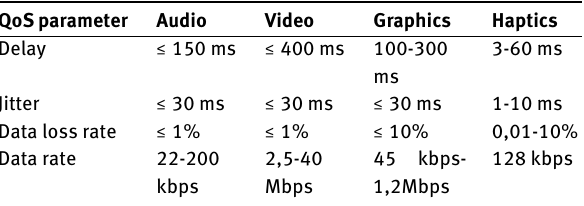
Table 1: Requirements for audio, video, graphics and haptics [31].